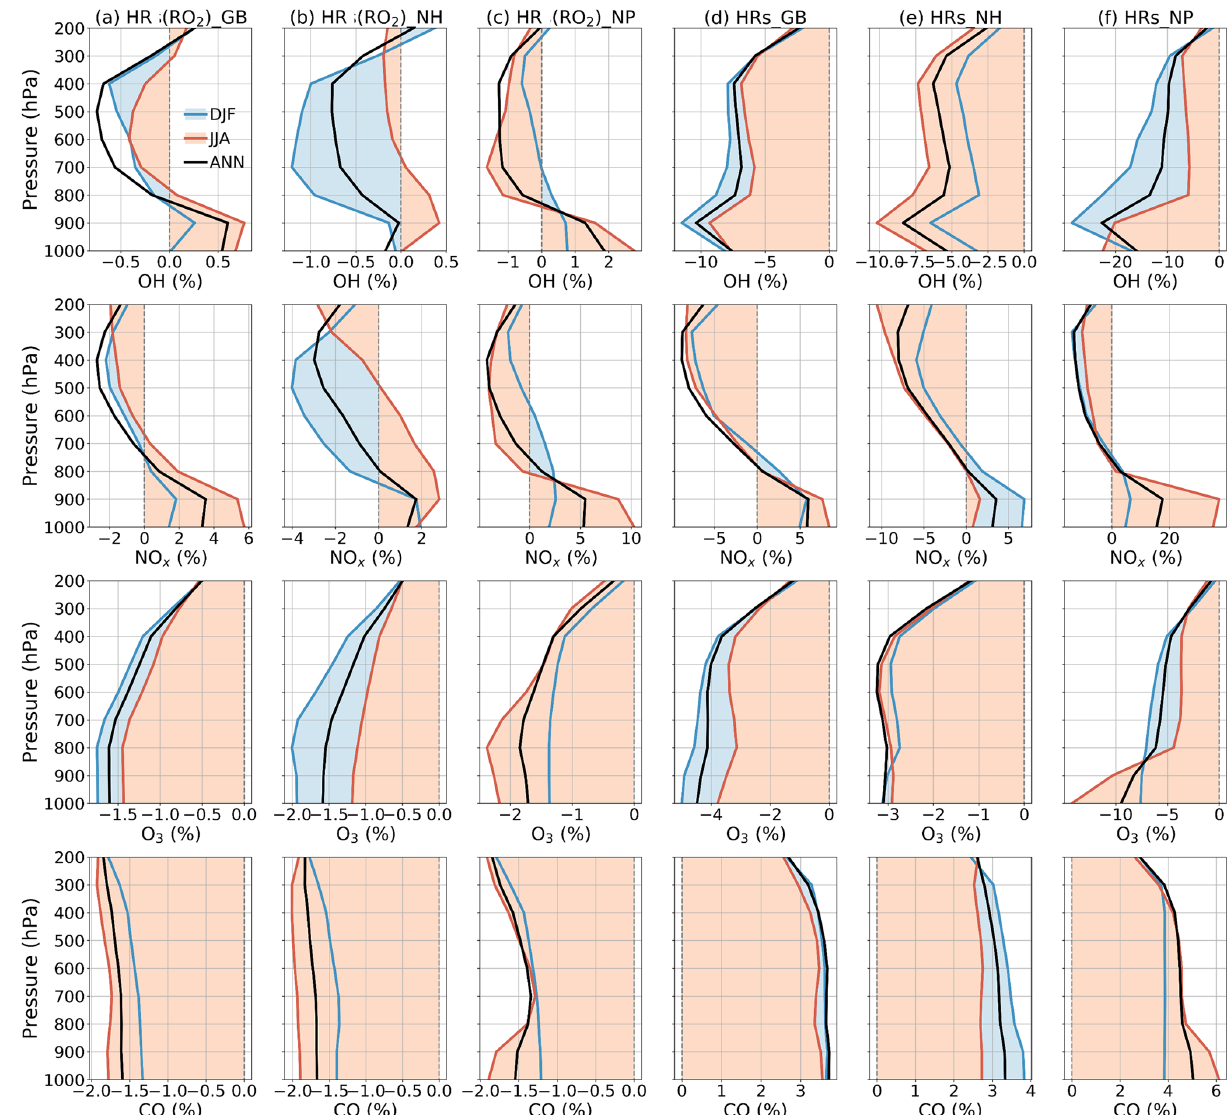
Figure 13. Averaged effects of HR(RO 2 ) (a–c) and all HRs (d–f) on OH (first row), NO x (second row), O 3 (third row), and CO (fourth row) for each air pressure range. Calculations are for global (a,d), Northern Hemisphere (b, e) , and North Pacific region (c, f) . Legend is on the first panel for December–January–February (DJF), June–July–August (JJA), and annual